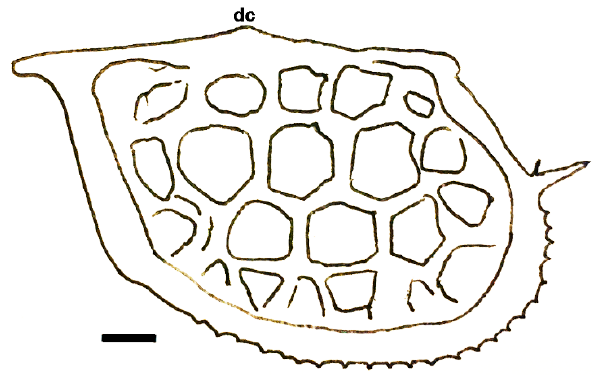
Figure 19. Jixinlingella daimonikoa . Anterior to left. Scale bar 200 microns. Abbreviation: dc , dorsal cusp. Image Credit: Mark McMenamin.